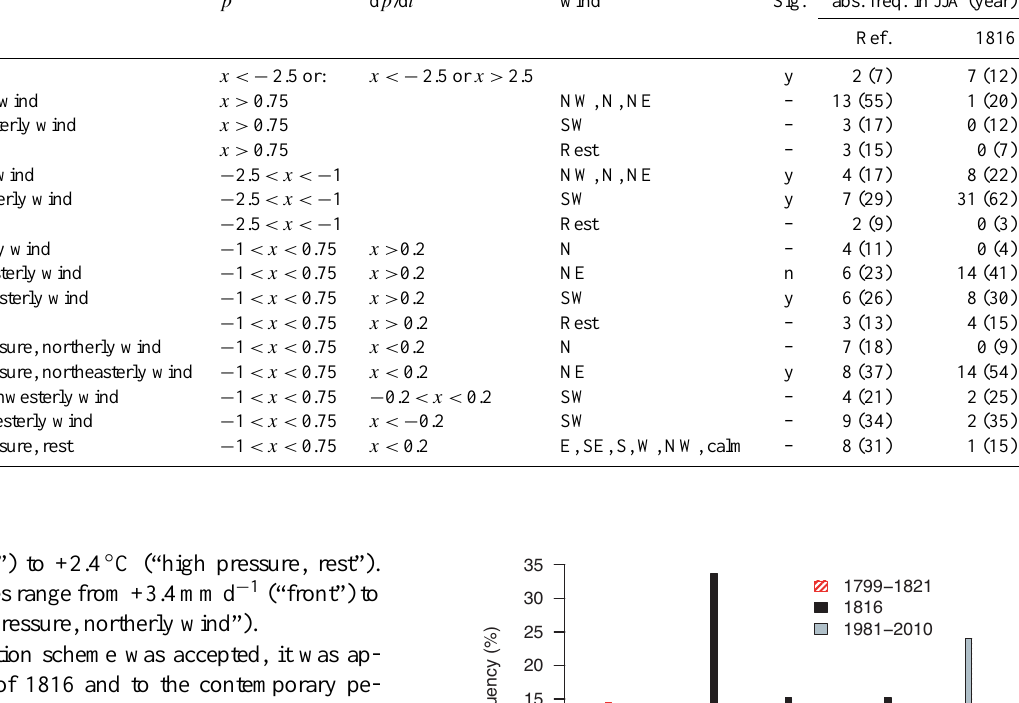
Table 2. Weather type classification. Note that days classified as “fronts” could theoretically also fit in other categories, but were attributed to “front” (in practice this occurred only rarely). The fifth column indicates whether significant ( p < 0.05) differences were found within this weather type between 1816 and the reference period according to a Wilcoxon test (y=yes, n=no, –=not enough cases). The sixth column indicates mean absolute frequencies of a weather type in the reference period for an average summer, JJA (annual averages). The last column indicates absolute frequencies of a weather type for summer 1816, JJA, in brackets: frequencies for the entire year 1816. Class p d p /d t wind Sig.